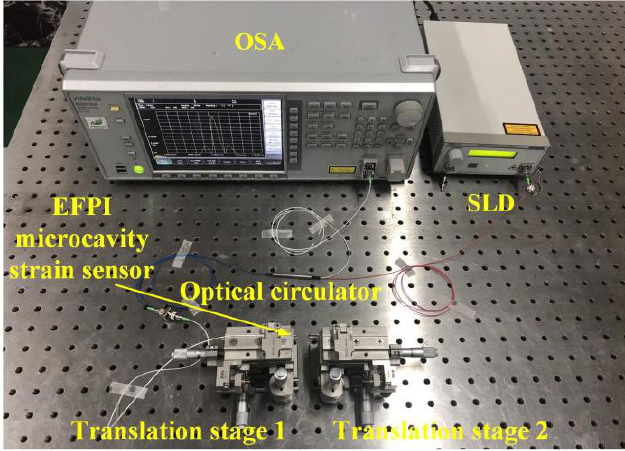
Figure 4. Photograph of the experimental system with the EFPI microcavity fiber-optic strain sensor. Two capillary ends of the sensor were fixed on the pair of translation stages through 502 glue. Axial direction moving of the translation stages is used to impose strain on the glass capillary of the sensor.